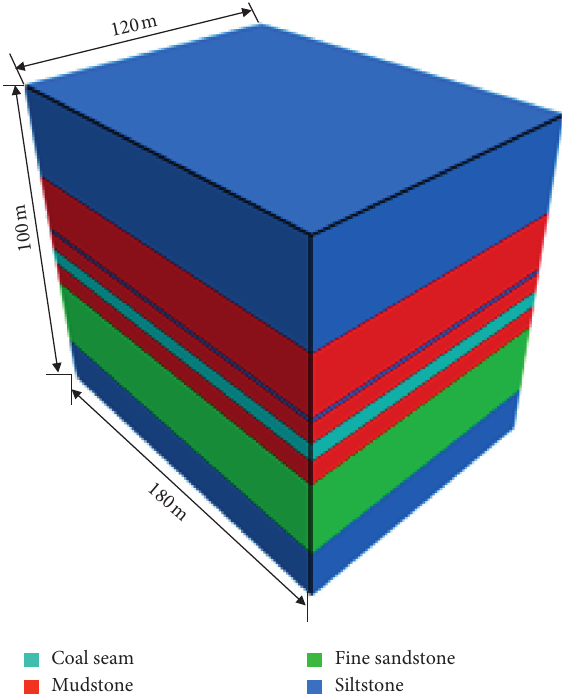
Figure 4: Numerical simulation model of mining roadway. Table 2: The physical and mechanical parameters of surrounding rock.